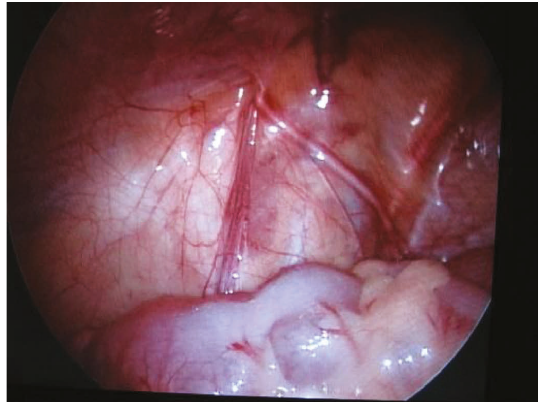
Figure 3: Laparoscopic image of left inguinal ring showing well- developed spermatic vessels and vas entering the inguinal canal.